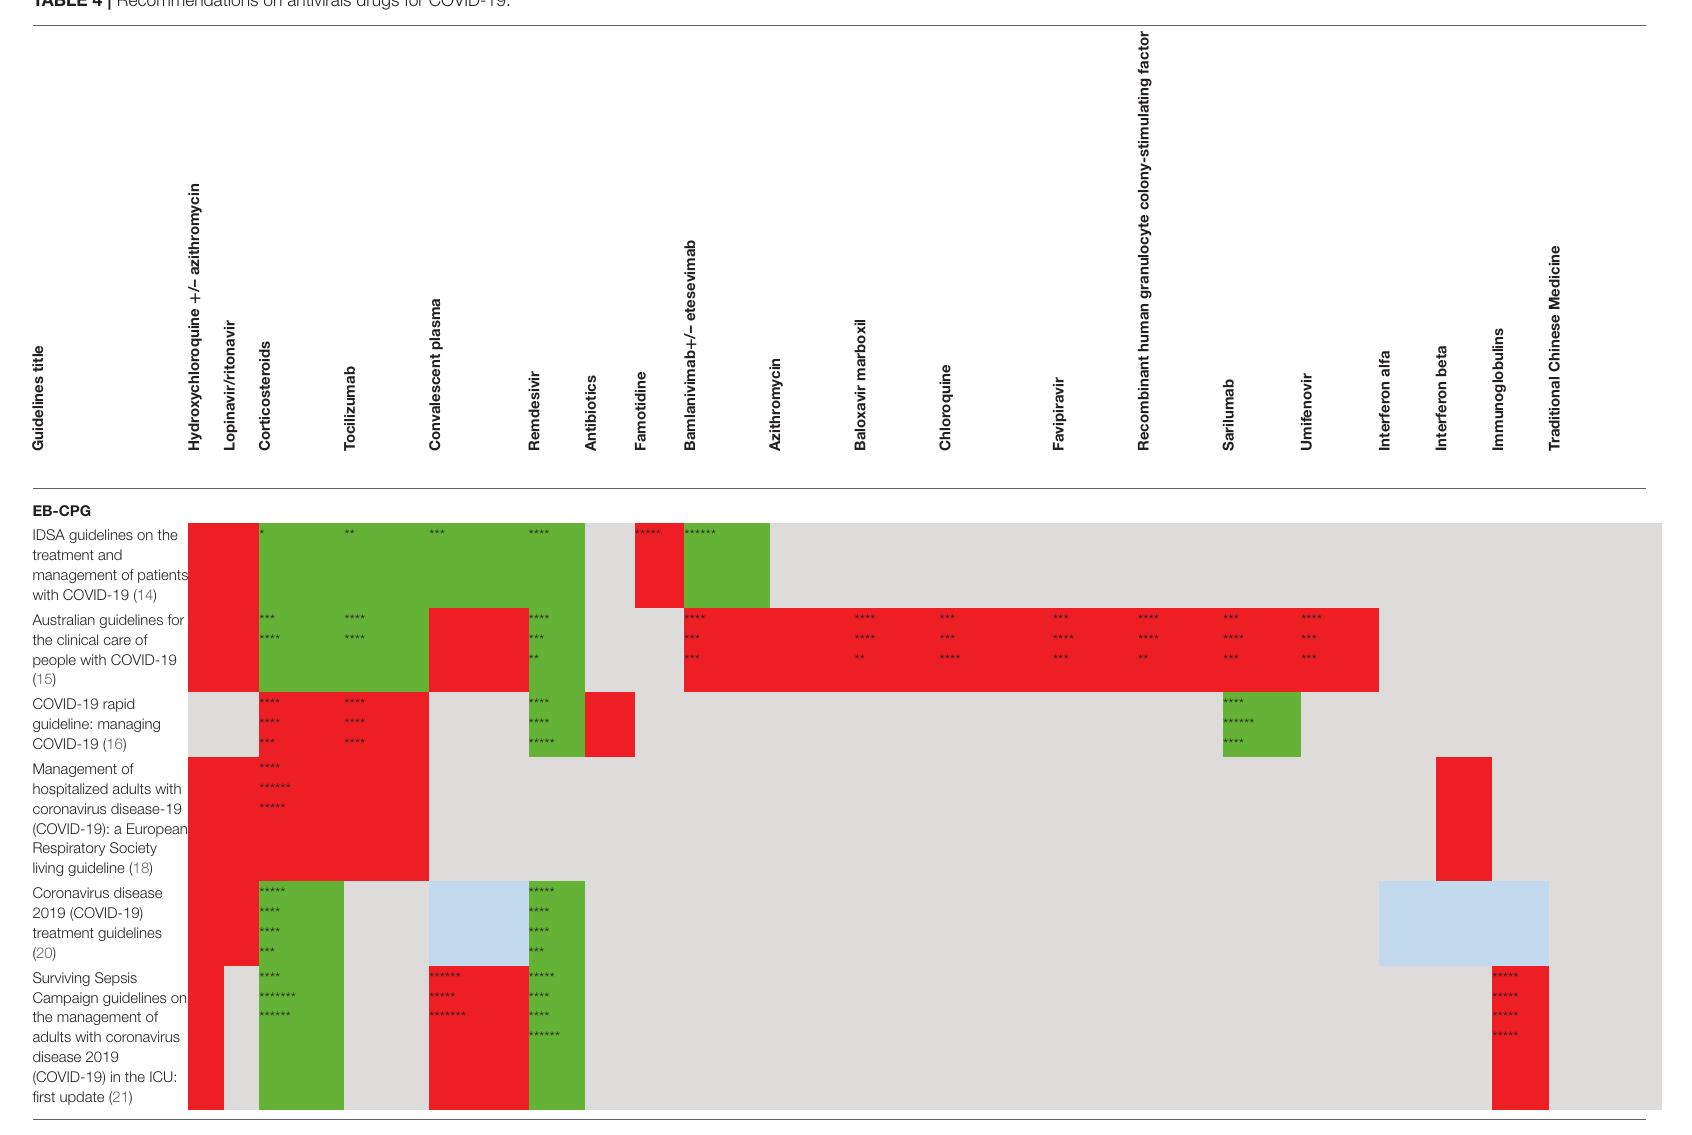
TABLE 4 | Recommendations on antivirals drugs for COVID-19.